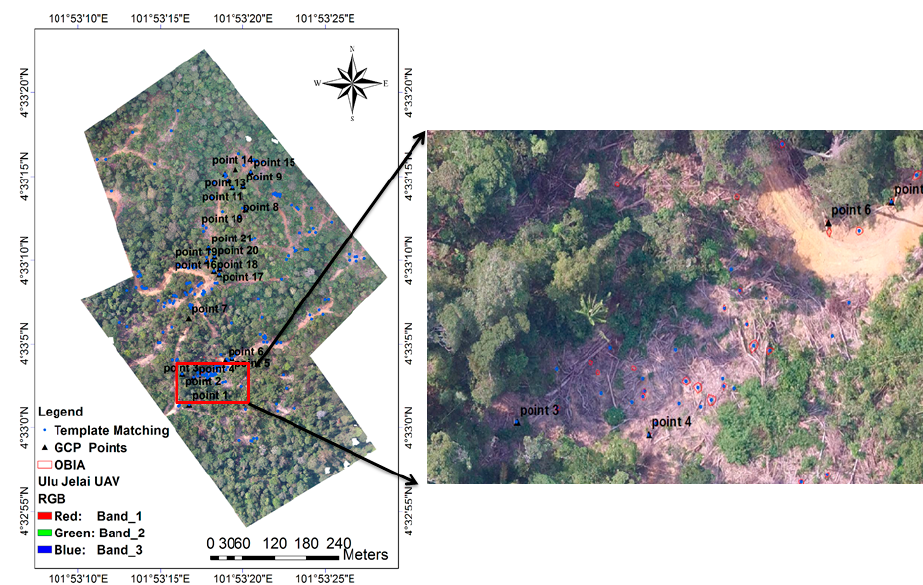
Figure 9. Map of stumps detection by using integration of TM and OBIA approach.